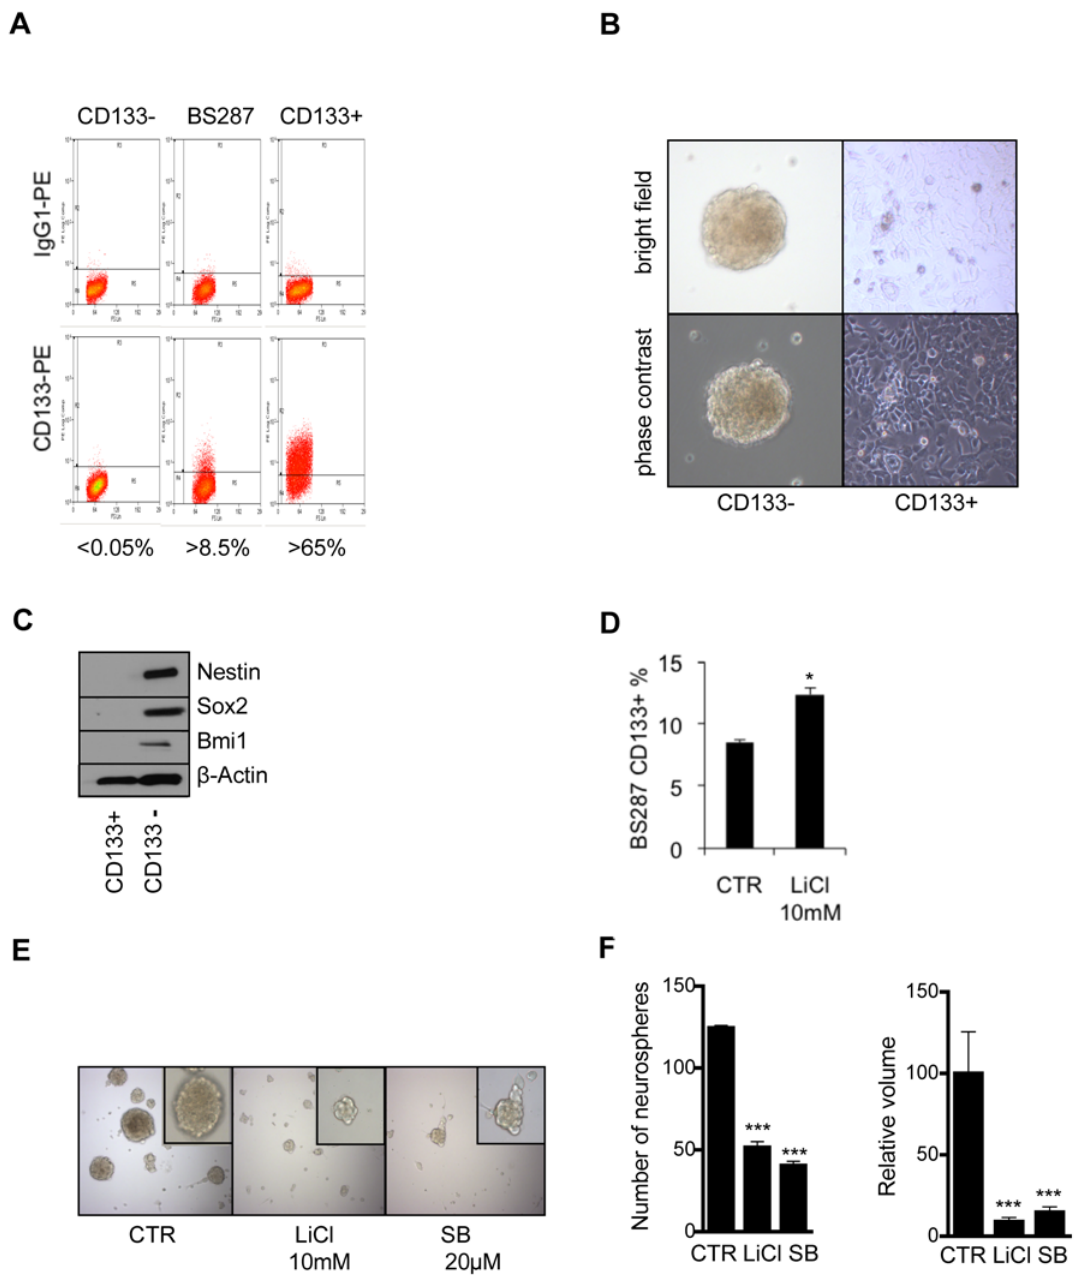
Figure 6. GSK3 b inhibition reduced stem cell characteristics in an ‘‘ exvivo ’’ GBM cell line. (A) CD133 sorting of the BS287 ‘‘ ex vivo ’’ GBM cell line. (B) Growth characteristics of the CD133 + and CD133- populations in BS287. (C) Western blot analysis of Nestin, Sox2, Bmi1 and b -actin in BS287. The CD133- population showed stem cancer-like characteristics. (D) Cells in the CD133 + population with a more differentiated geno/ phenotype increased after GSK3 b inhibition. (E, F) Inhibition of GSK3 b led to a reduction in the number and volume of neurospheres in the BS287 ‘‘ ex vivo ’’ cell line. doi:10.1371/journal.pone.0007443.g006 cell-like characteristics. Expression of stem cell and differentiation markers more accurately defined the subpopulation of cells within GBM cell lines and ex vivo tumor cells than expression of the CD133 marker. Inactivation of both Bmi1 and GSK3 depleted precursor cells required for tumor maintenance and progression.